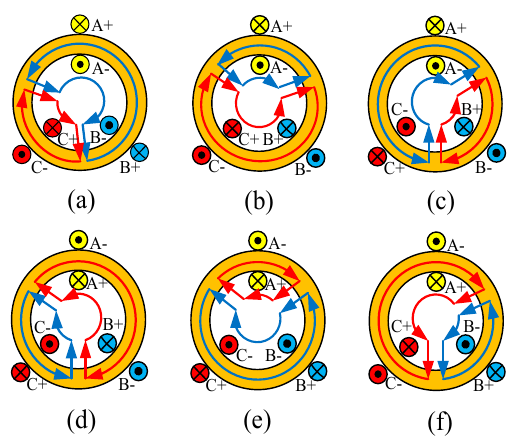
Figure 3. Armature magnetic fields of the motor at different points: ( a ) armature magnetic field at point 1, ( b ) armature magnetic field at point 2, ( c ) armature magnetic field at point 3, ( d ) armature magnetic field at point 4, ( e ) armature magnetic field at point 5, ( f ) armature magnetic field at point 6.